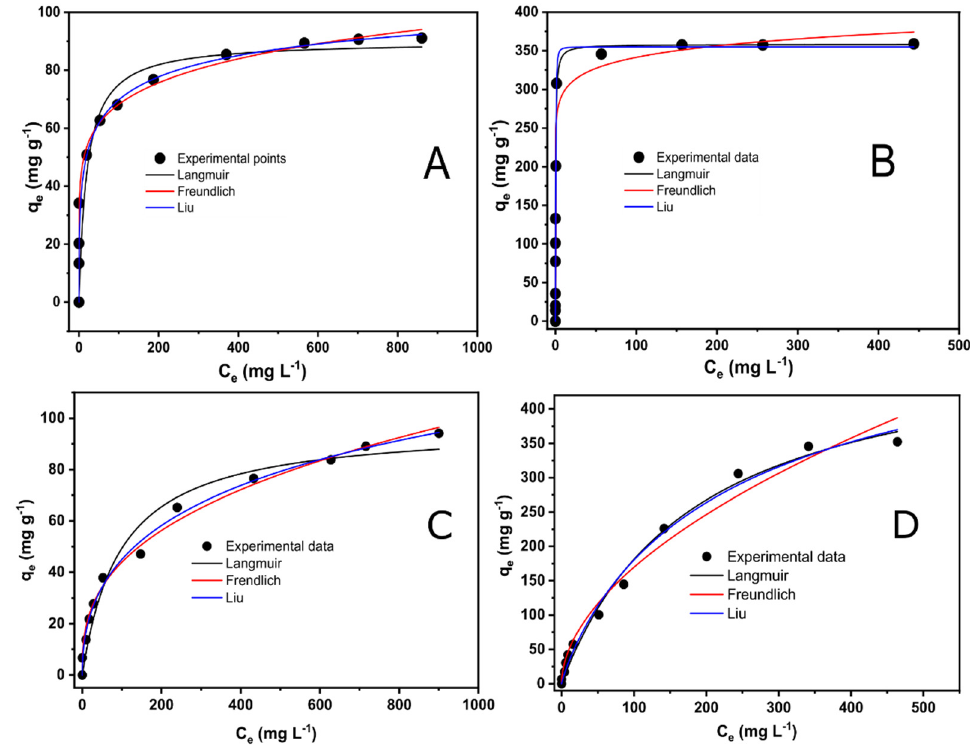
Figure 8. Isotherms of adsorption for RO-16 onto ZnCl 2 -BBC ( A ) and KOH-BBC ( B ) and for RB-4 onto ZnCl 2 -BBC ( C ) and KOH-BBC ( D ). Contact time 6.5 and 3.5 h for ZnCl 2 -BBC and KOH-BBC for RO-16, respectively; and 7.5 and 3.6 h for ZnCl 2 -BBC and KOH-BBC for RO-16, respectively; Initial pH of 5.5 and 4.0 for RO-16 and RB-4, respectively; the adsorbent dosage of 1.5 g L − 1 . Table 6. Equilibrium parameters of RO-16 and RB-4 onto KOH-BBC and ZnCl 2 -BBC.